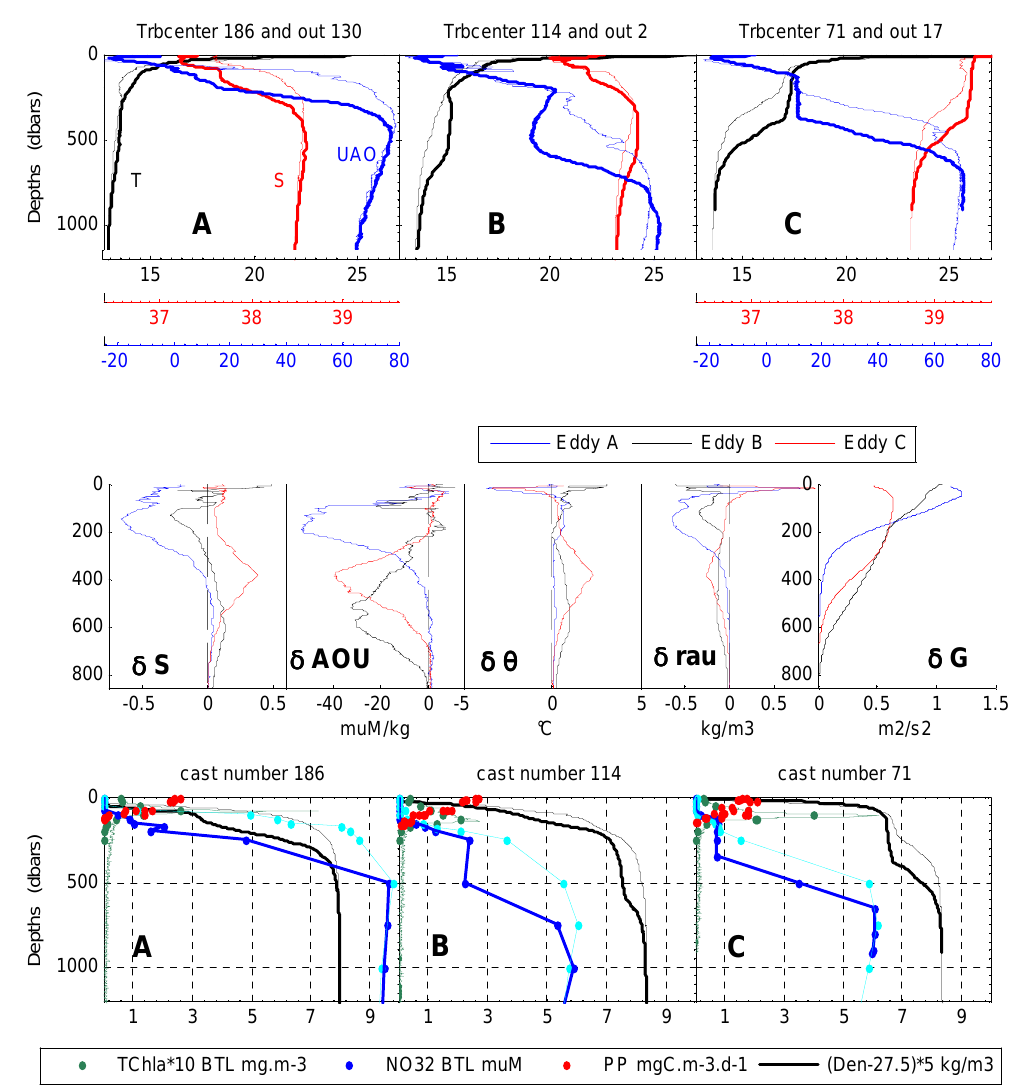
Fig. 8. Top: vertical profiles of θ ( ◦ C in black), S (PSU in red) and AOU (µmolkg − 1 in blue) vs. pressure (0–1500dbars) inside the eddies (thick lines; casts 186, 114 and 71 for LD stations A, B and C, respectively) and outside but from the closest SD station (thin lines; casts 130, 2 and 17 for SD stations, respectively). The same scales for each LD station A, B, and C with the corresponding colours are reported below. Middle: vertical profiles of S , AOU, θ and G anomalies from left to right. Depths of top and bottom anomalies indicated in Table 2 are clearly shown by values close to zero. Bottom: vertical profiles of primary production (*: mgCm − 3 d − 1 ) , total chlorophyll a * 10 (green − 1 ) and density (( ρ – 27.5)*5, – : kg m − 3 ) vs. pressure ∗ for HPLC measurements and – for fluorescence converted measurements: µgL (dbars) at the three LD stations (same casts as for Fig. 8 (top) but with rosette sampling except for density). Primary production was measured twice during the LD station occupation. Vertical profiles of nitrate concentration (µmolkg − 1 ) vs. pressure inside (dark blue ∗ ) and outside (light blue ∗ ) the eddies for the same cast and station as for AOU in the top